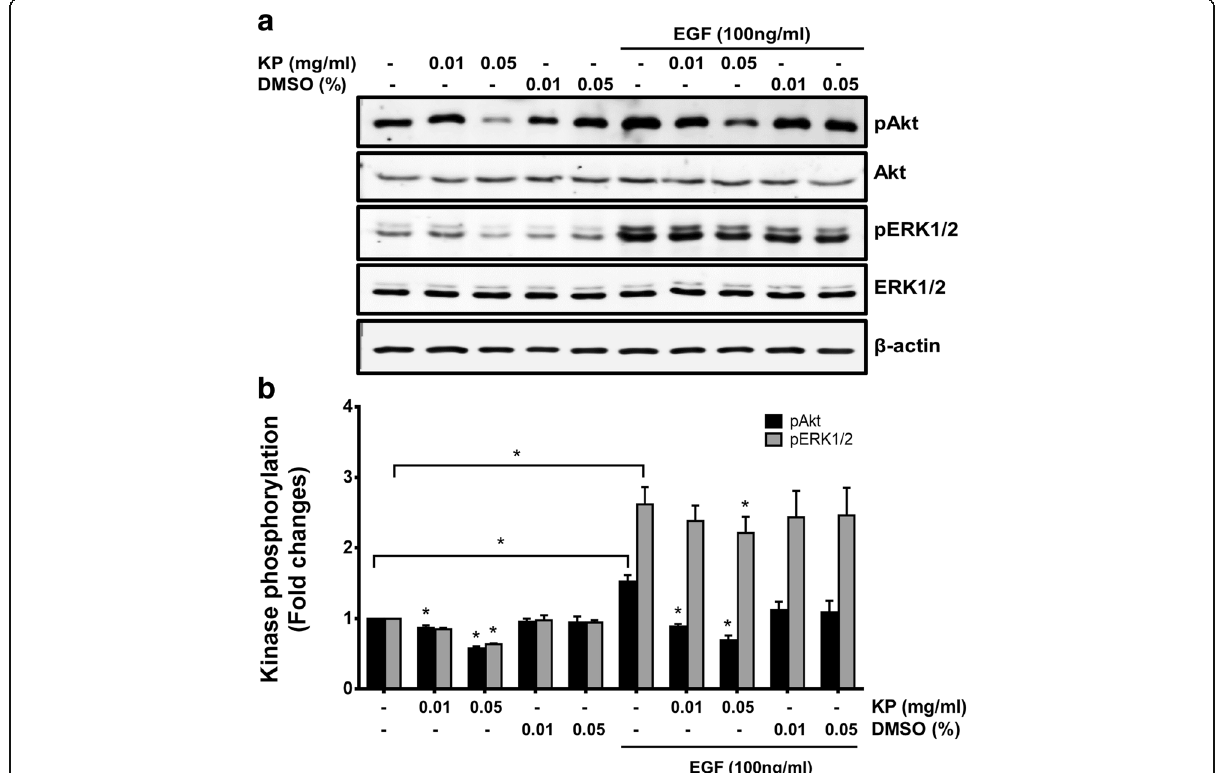
Fig. 5 The effect of KP on the PI3K/AKT and EKR1/2 MAPK signal transduction in SKOV3 cells. The immunoreactive bands of pAKT, AKT, pERK1/2 and ERK1/2 ( a ). Histogram of phosphorylation level of AKT and ERK1/2 ( b ). β -actin was used as a loading control. Data expressed as mean ± SD ( n = 3). * P <